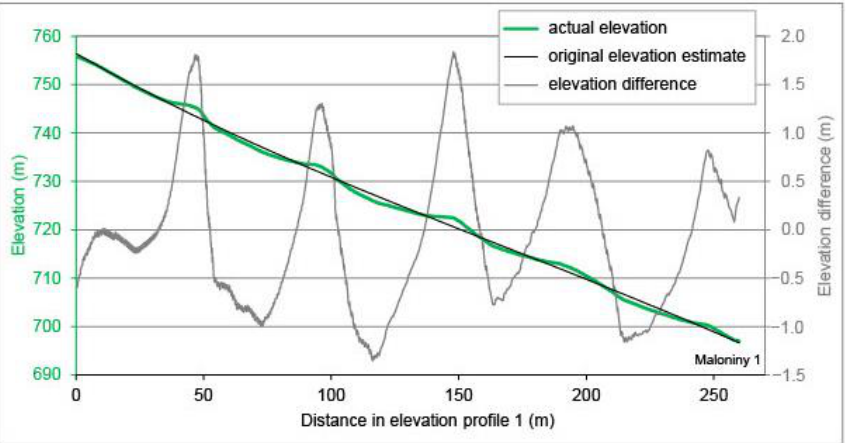
Figure 10. Elevation profiles from LiDAR data for the Maloniny 1 transect. The present-day eleva- tion (green line) was obtained from TIN. The original topography was estimated by the 5th order polynomial interpolation from LiDAR (black thin line). The grey line shows the difference between actual and inferred historical elevations [data sources: ZABAGED® — Altimetry —DMR 5G, ČÚZK, Praha, Czech Republic].